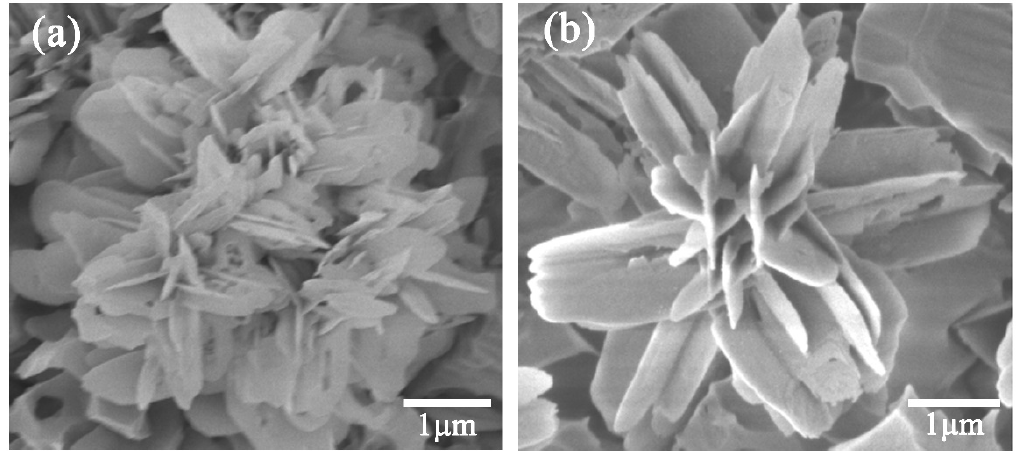
Figure 6. SEM images of ( a ) a single flower-like micro-cluster and ( b ) a single flower-like structure after nucleation at 680 °C for 4 h and crystallization at 790 °C for 4 h.